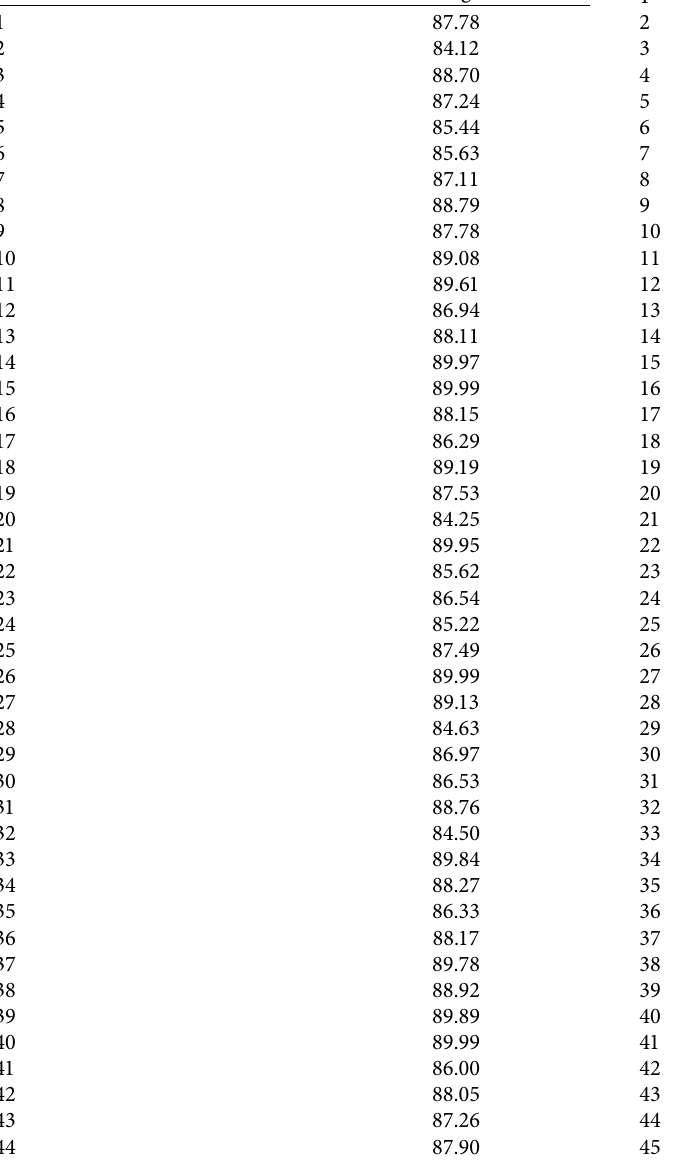
Table 2: Evaluation of land use spatial